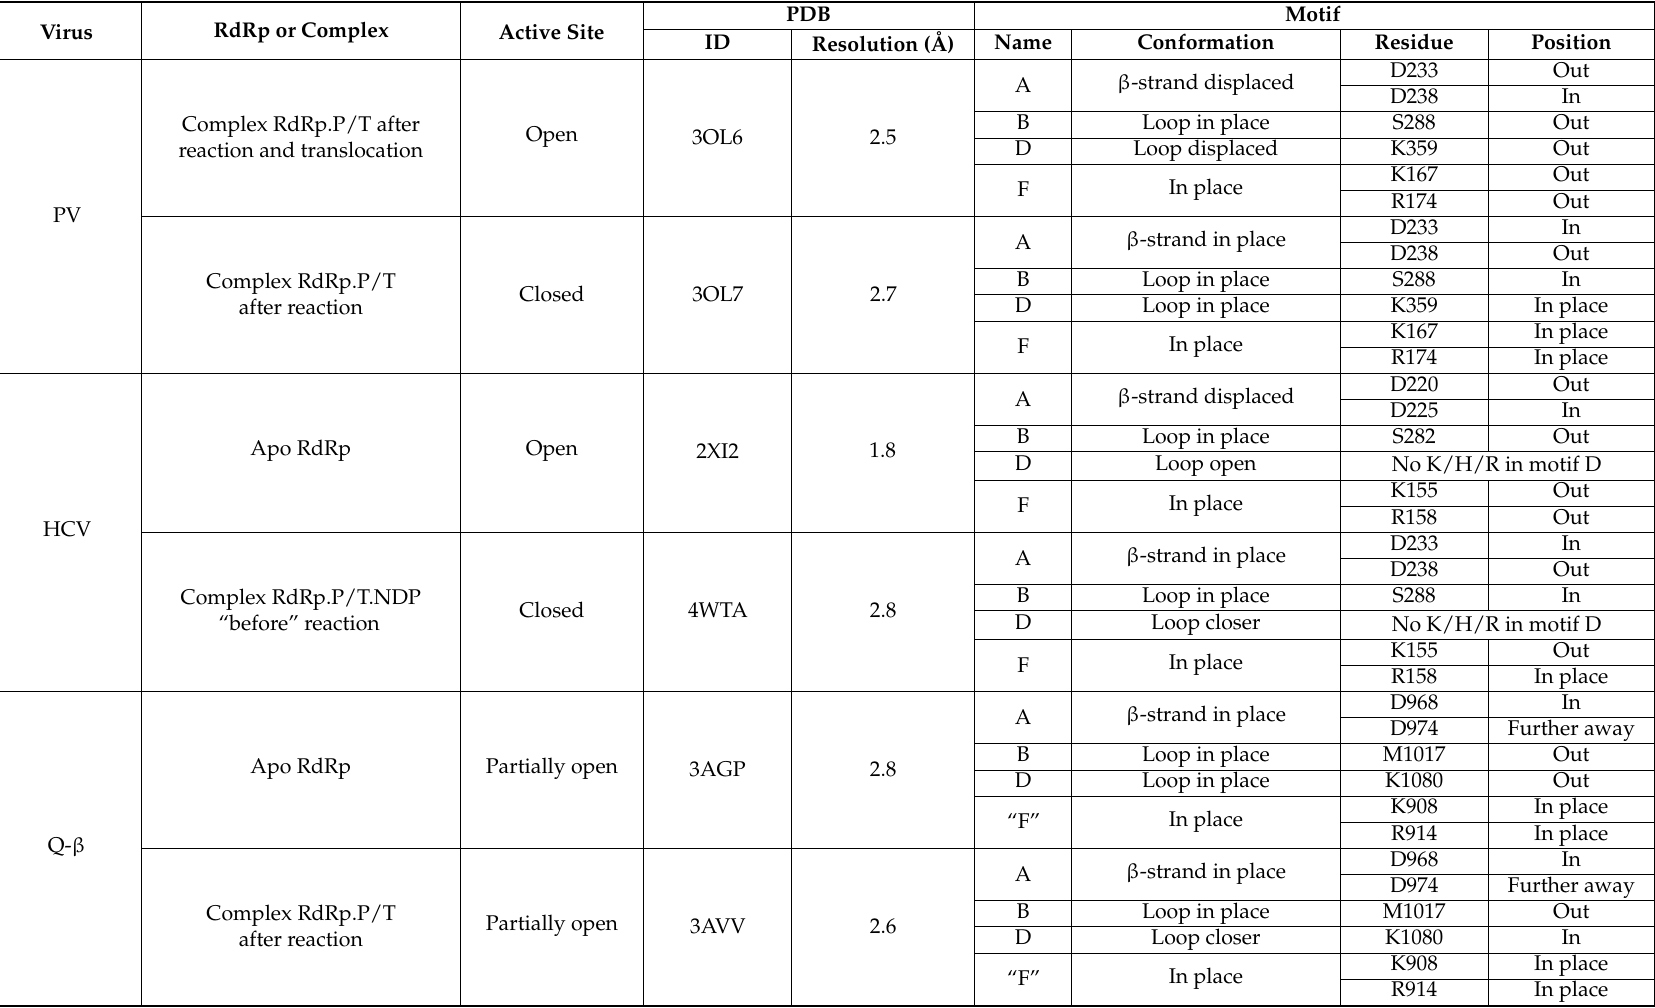
Table 1. Analysis of active site conformation of selected plus strand RNA virus RdRp